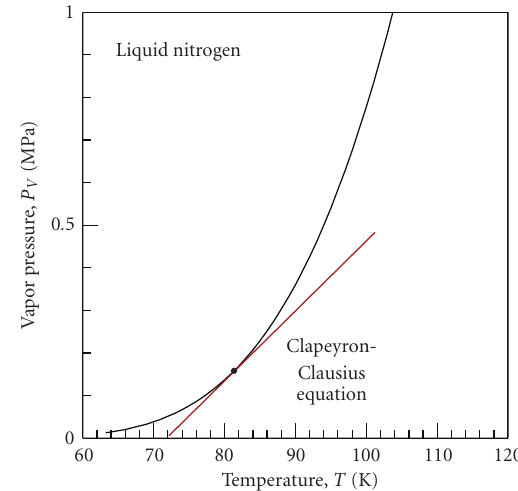
Figure 7: Saturation curve for nitrogen.